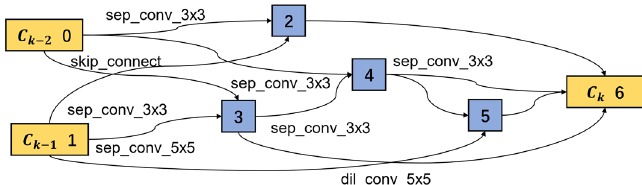
Figure 16. Optimal normal cell structure for RUL prediction.